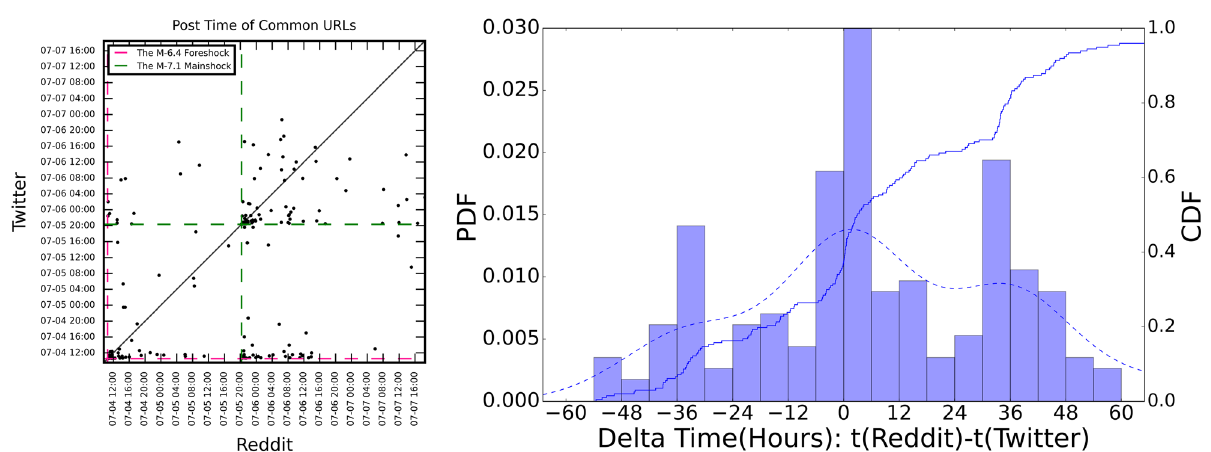
Figure 5. Common URLs’ post time and response time difference on two OSNs. The dashed line and solid line in the right plot correspond to the PDF curve and CDF curve of response time difference,